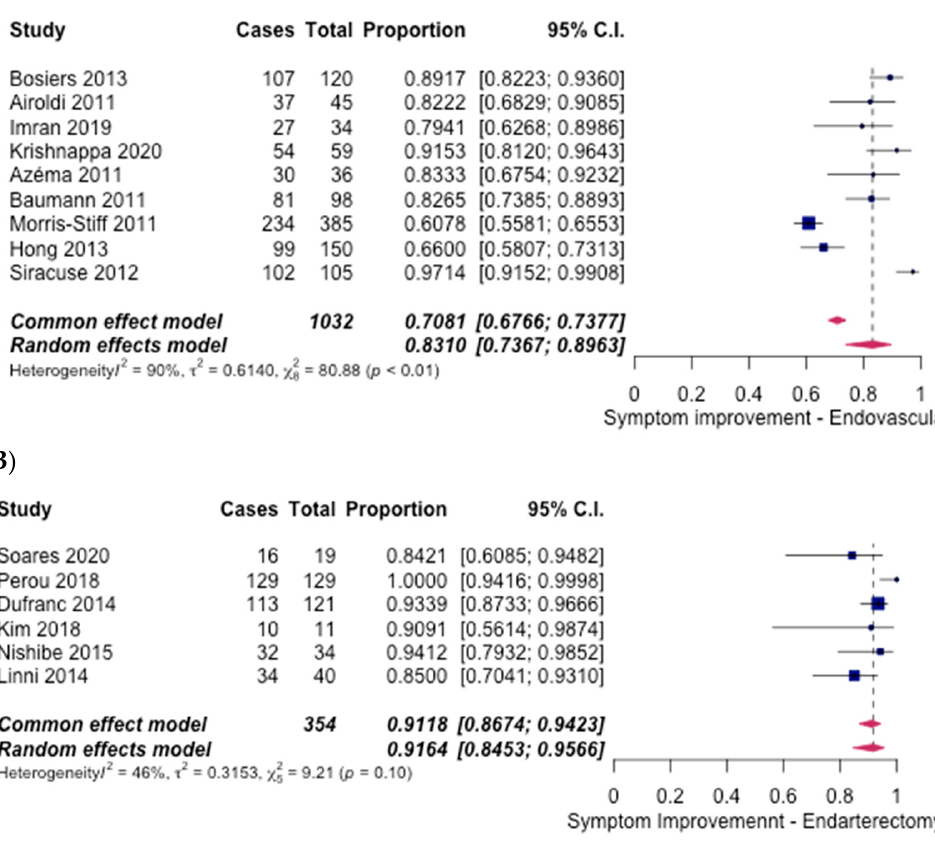
Figure 4. Forest plot for symptom improvement. ( A ) Endovascular intervention [8,9,14–20]. ( B ) Endarterectomy [5,6,23–26].